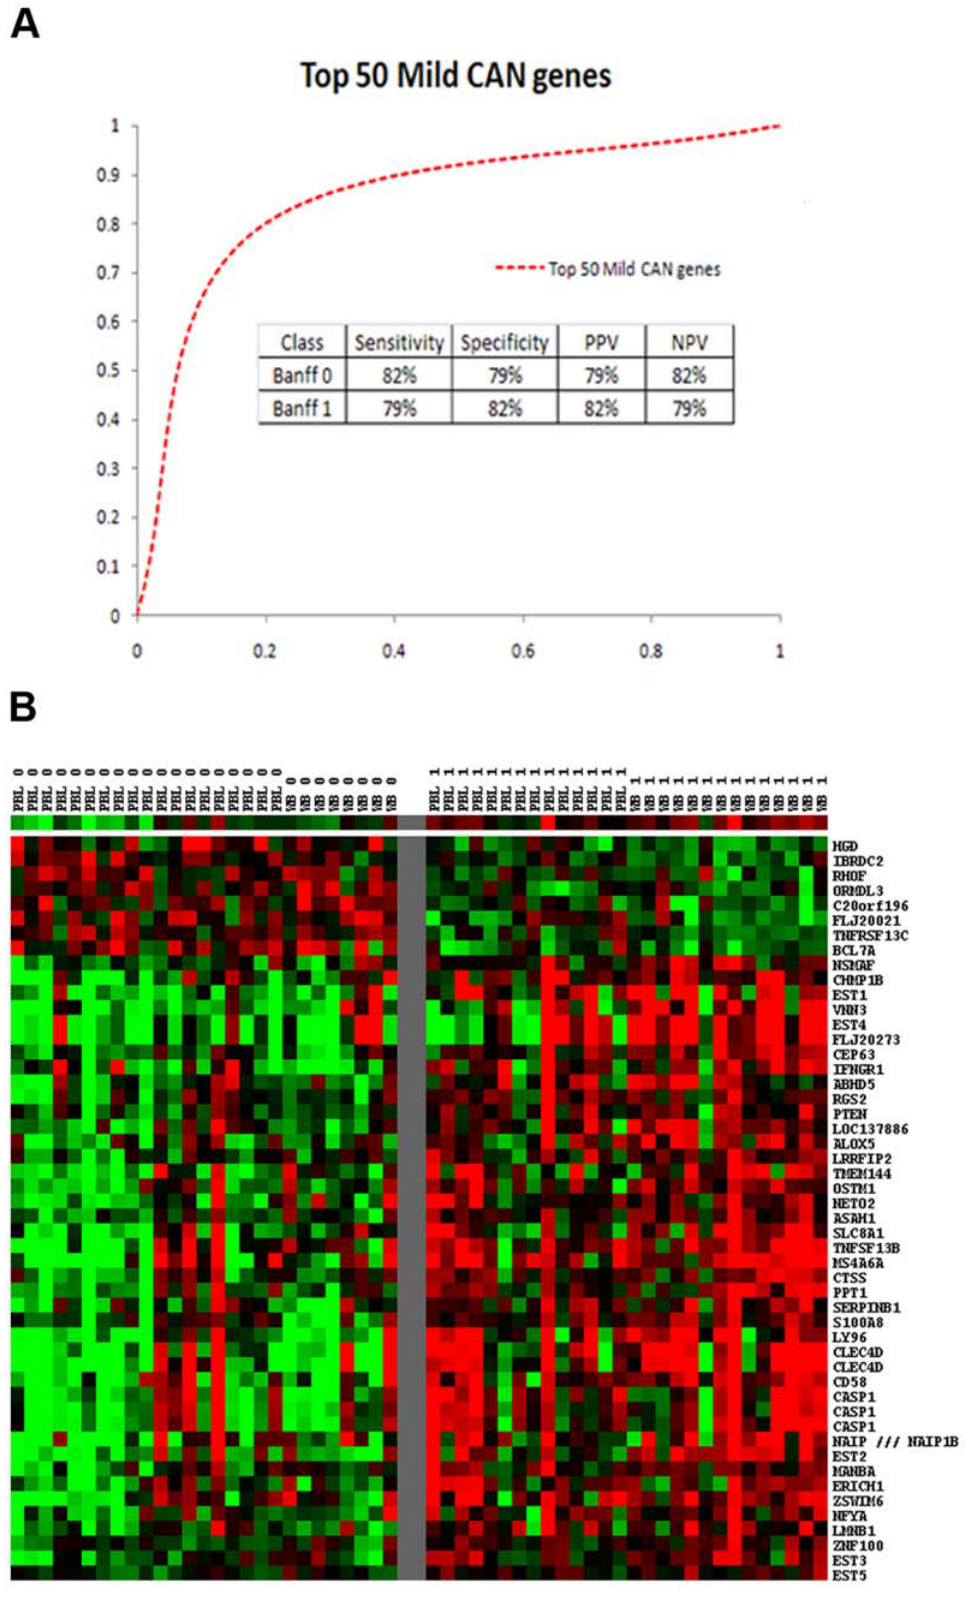
Figure 2. Class prediction analysis of Banff 0 vs. Banff 1 (mild CAN) based on Diagonal Linear Discriminant Analysis for the top 50 Banff 0 vs. Banff 1 consensus genes ranked by p values. A) depicts the Receiver Operating Characteristic (ROC) curves and provides the Sensitivity, Specificity, Positive Predictive Value (PPV) and Negative Predictive Value (NPV); B) depicts the heat map classifying Banff 0 vs. Banff 1 using the top 50 consensus genes where (red) is up-regulated and (green) is down-regulated. doi:10.1371/journal.pone.0006212.g002 PLoS ONE |